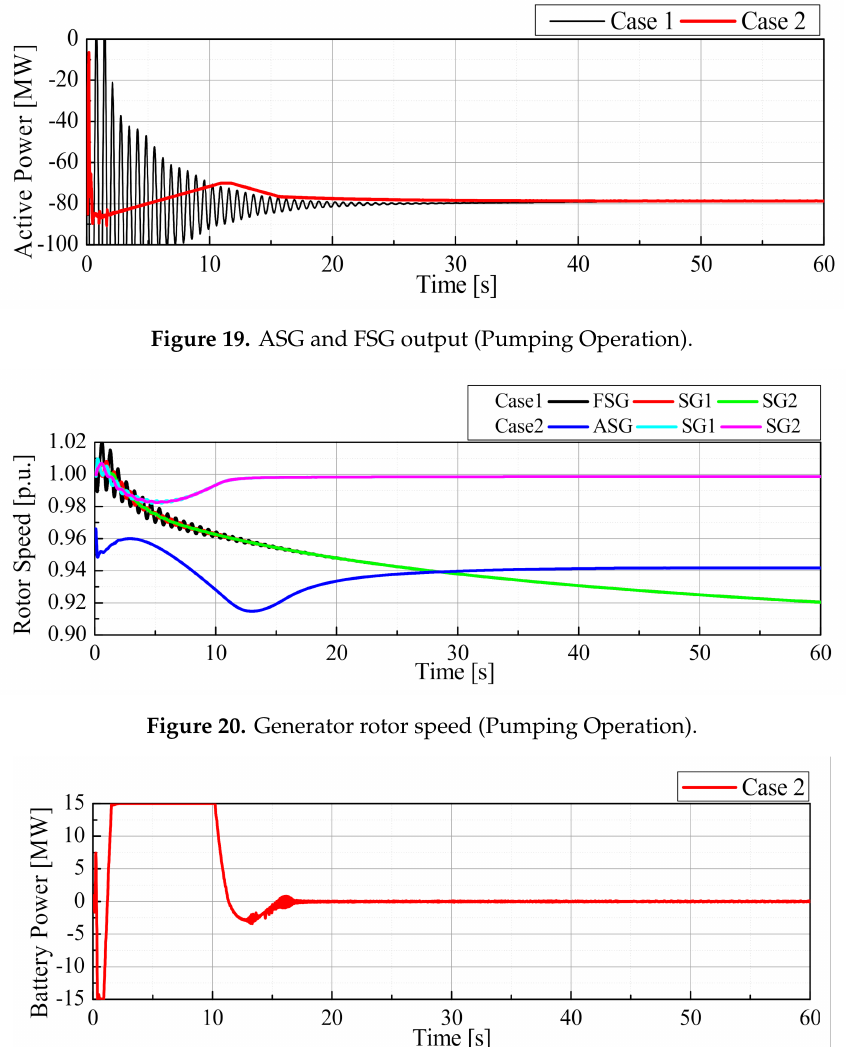
Figure 21. Battery output (Pumping